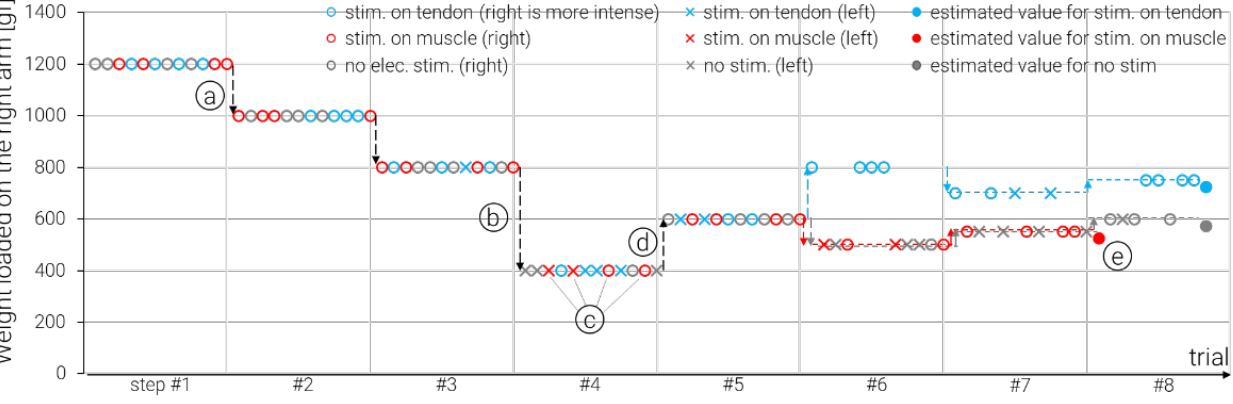
Figure 2. Example of the experimental procedure. In each step, the three conditions’ trials were conducted randomly. All conditions’ steps were simultaneously changed after all the transitions of steps were decided. ( a ) The first step size was 200 gf (rule #1). ( b ) Since the previous two steps moved in the same direction, this step size was be doubled (rule #3). ( c ) For step #4 under the EMS condition, the answers were 2:2, so an additional trial was conducted at the last of this step (rule #2). In this case, he answered as more intense for the left, so the step went up. ( d ) Since the direction was flipped, the step size was halved (rule #3). ( e ) The step size got to 25, and the EMS’s condition procedure was stopped (rule #4).